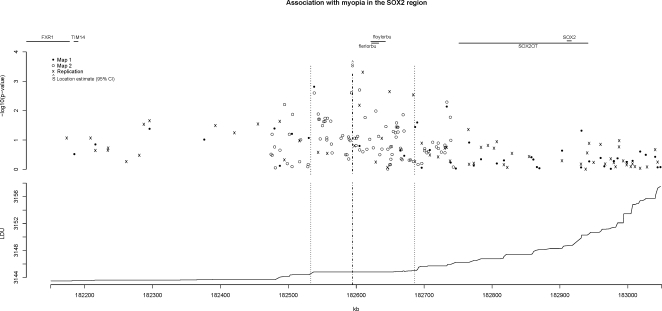
Association with myopia upstream from the SOX2 region.Legend notes from Figure 3 apply. See Figure S2 for pair-wise LD plot of region.